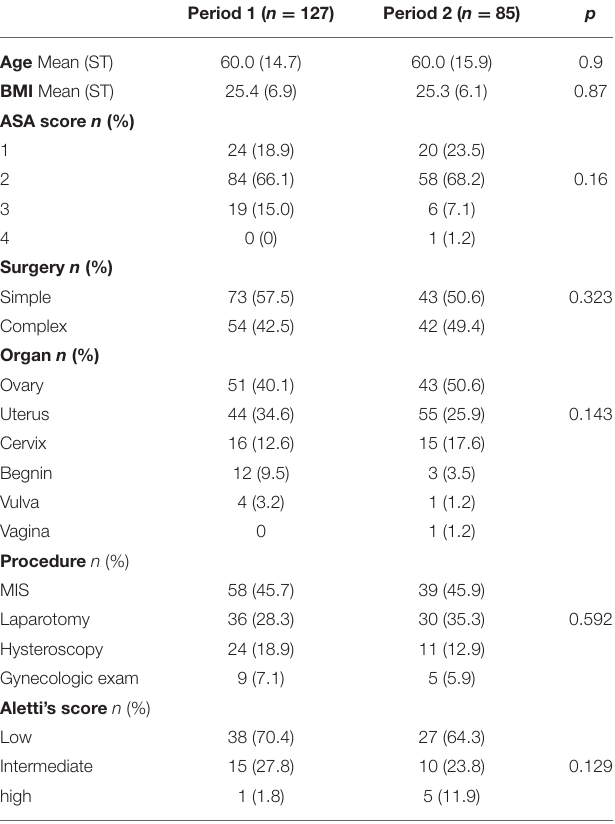
TABLE 1 | Description of populations and surgical procedures during the two periods.